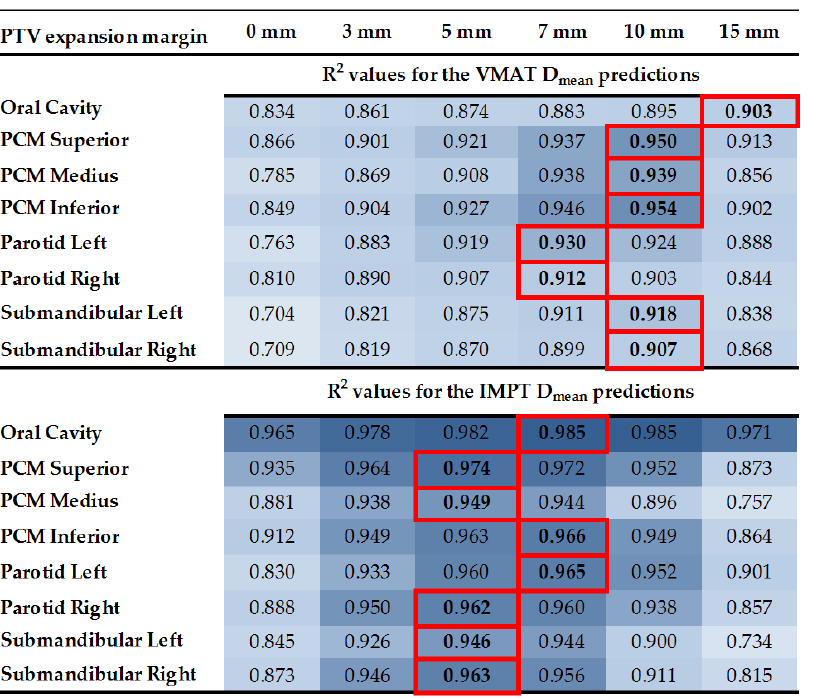
Figure 3. Assessment of the best performing PTV expansion margin to predict IMPT and VMAT OAR D mean . The R 2 values are given with the highest R 2 values for each OAR are outlined in red. The values become higher as the color of the cells gets darker.